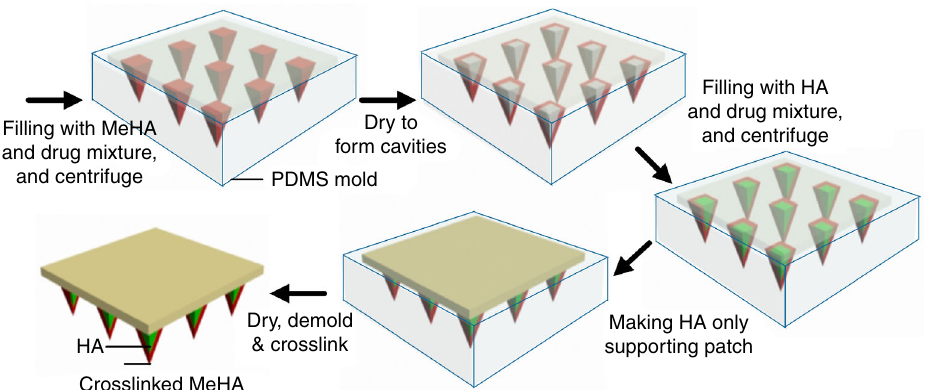
Fig. 2 Schematic illustration. Fabrication process of the polymeric patch with an array of needle-shaped and